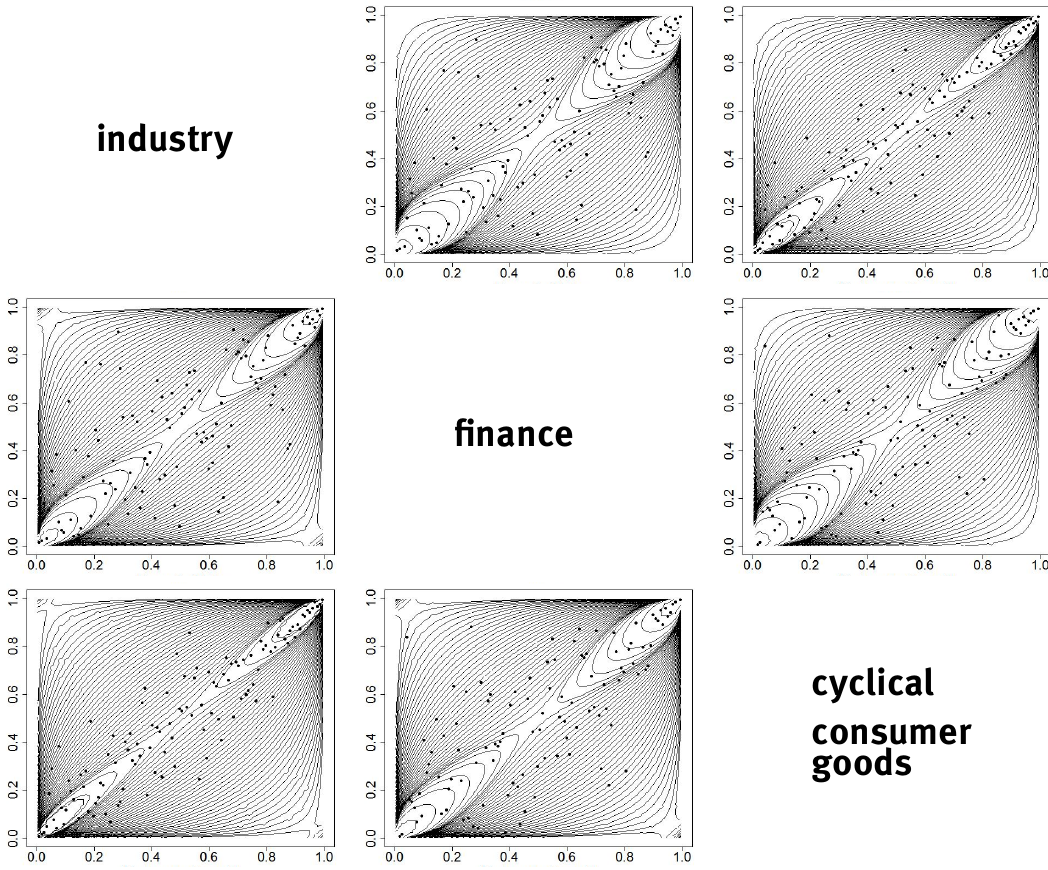
Fig. 3. Fitted Gaussian and t-copula together with empirical